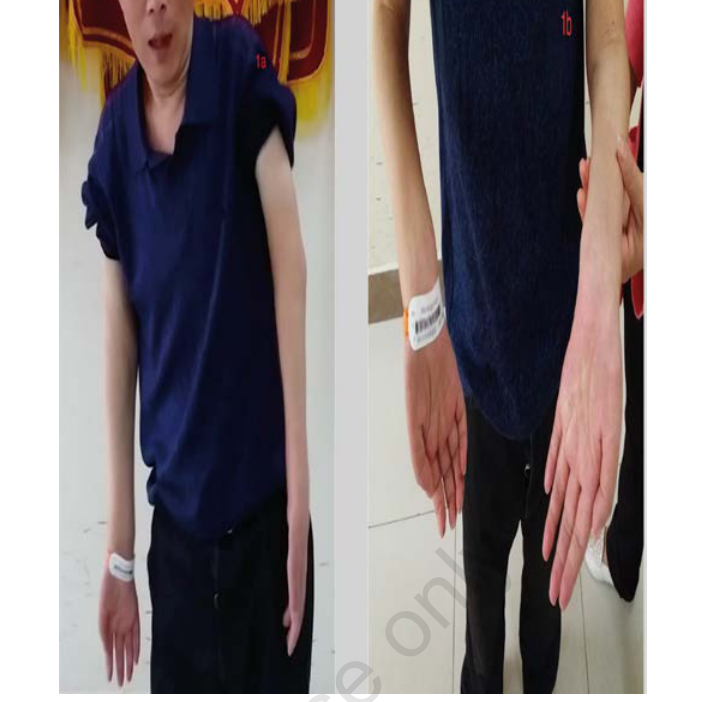
Figure 1. Physical examination showing patient’s upper extremities with severe atrophy of forearm extensors (A) and flexors (B).